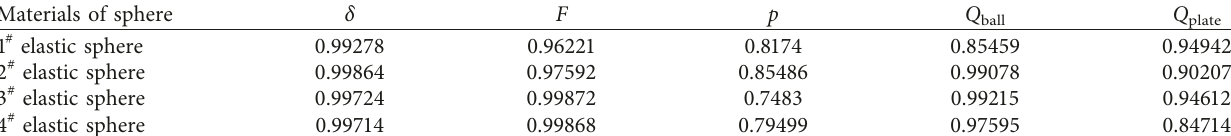
Table 3: The linear correlation coefficient R 2 between the simulated values and theoretical